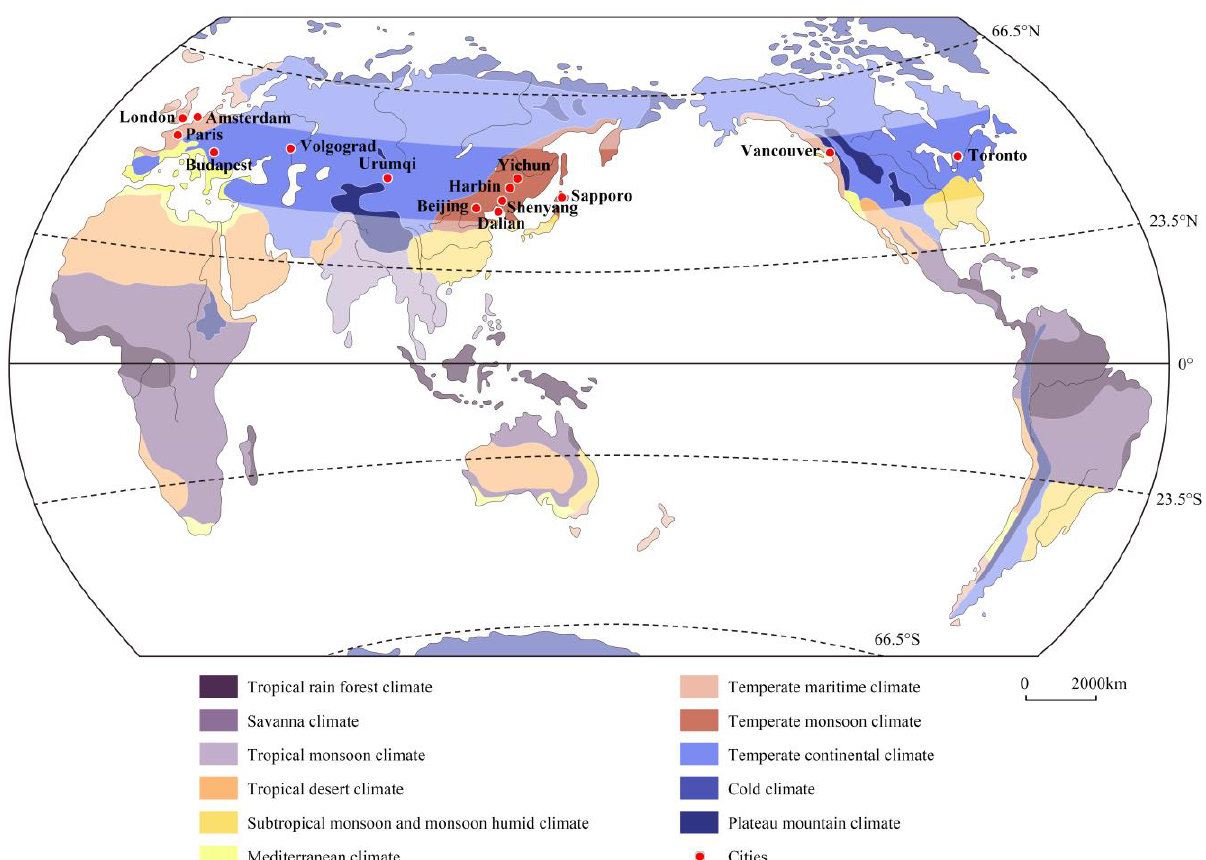
Figure 16. World climate zoning map; drawn by the authors.